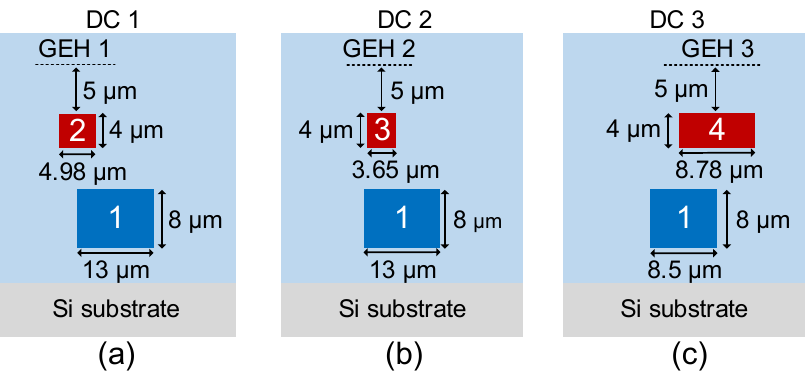
Figure 4. The dimensions of three vertical DCs with GEHs for switching ( a ) the E 21, ( b ) the E 12 and ( c ) the E 11 modes.